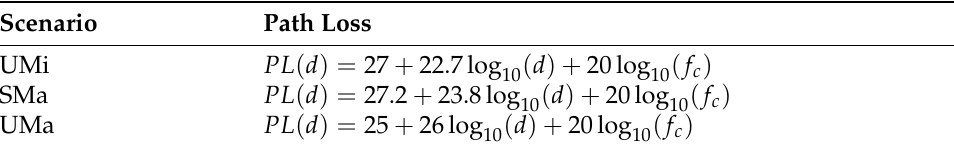
Table 4. Path loss under different